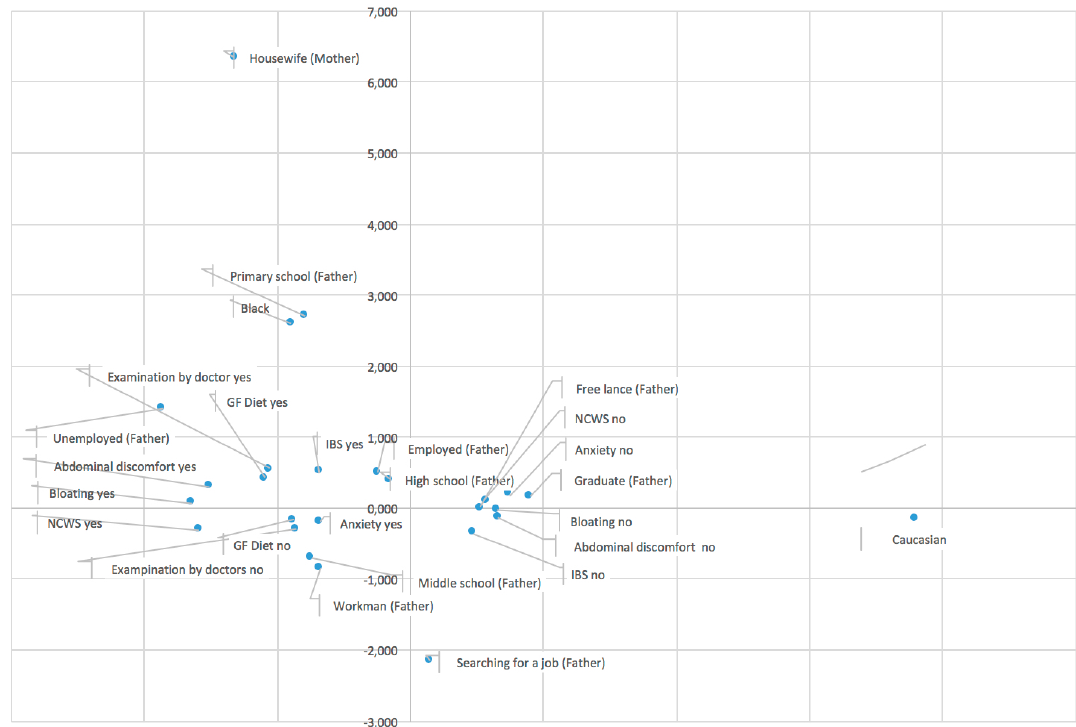
Table 2. Diseases previously diagnosed in subjects with self-reported NCWS and in controls. Number and percentage are given.